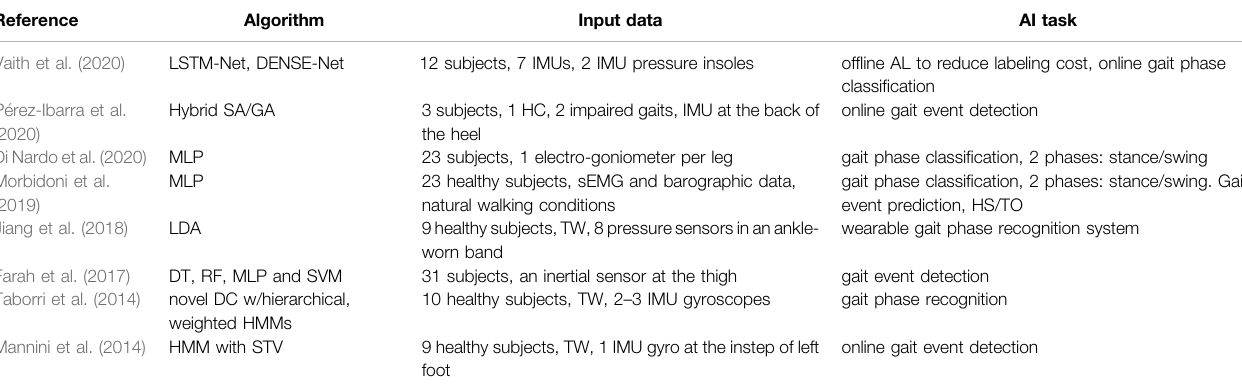
TABLE 2 | Gait phase recognition and gait event